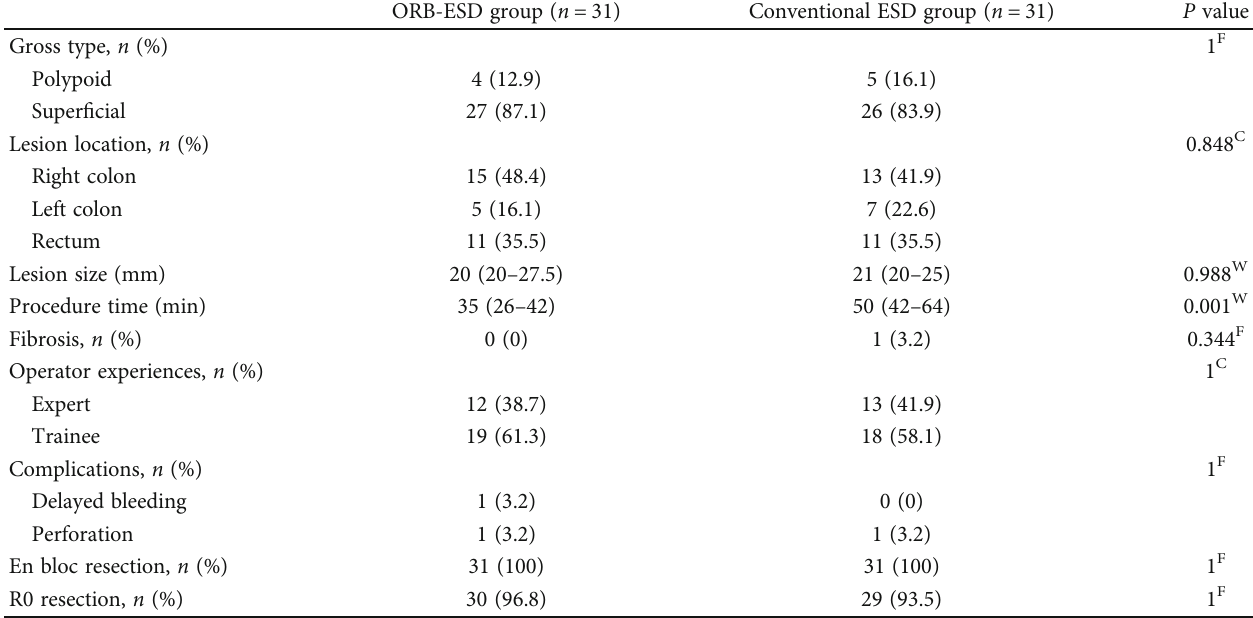
Table 3: Variables included in the propensity score matching, and treatment outcomes in the matched